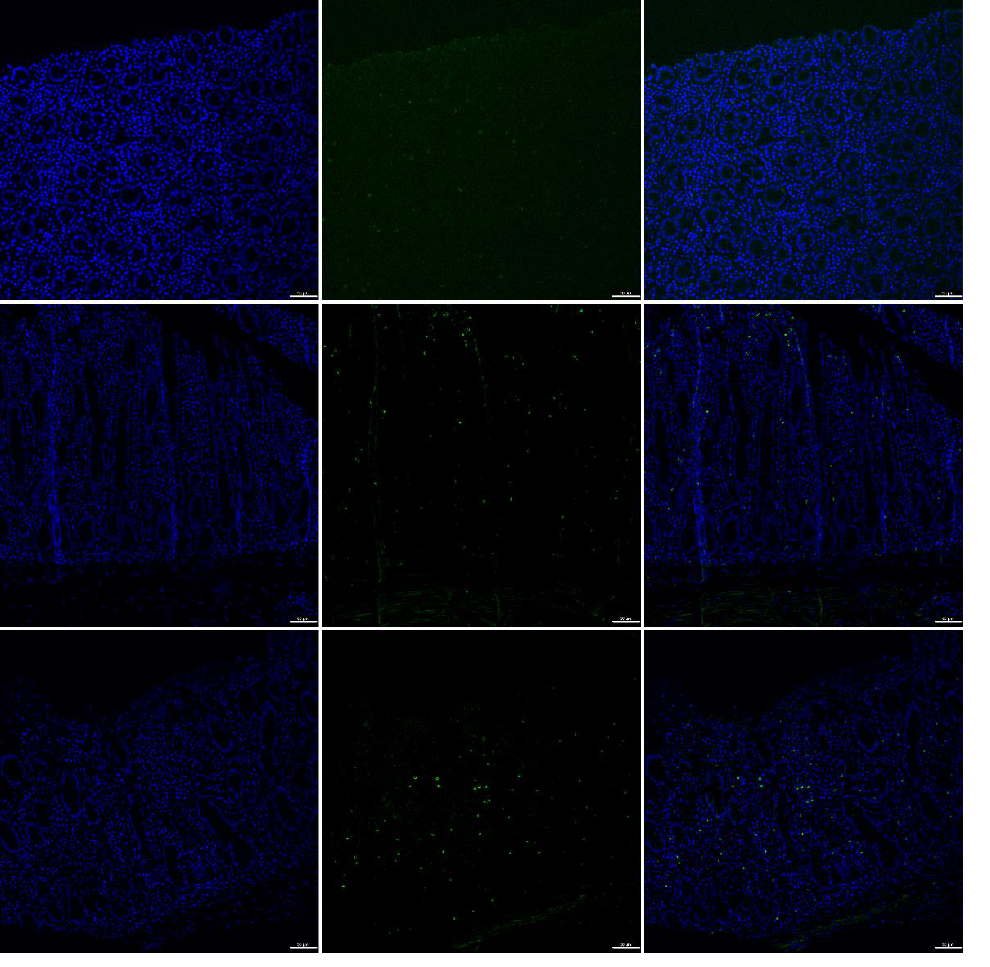
Figure 9. Ex vivo permeation test on intestinal tissue after 1 h: untreated intestinal mucosa, intestinal mucosa treated with free fluorescein solution, and intestinal mucosa treated with F-SLN. Signal (green) / Hoechst 33342 nuclei (blue). Bar: 50 µm.